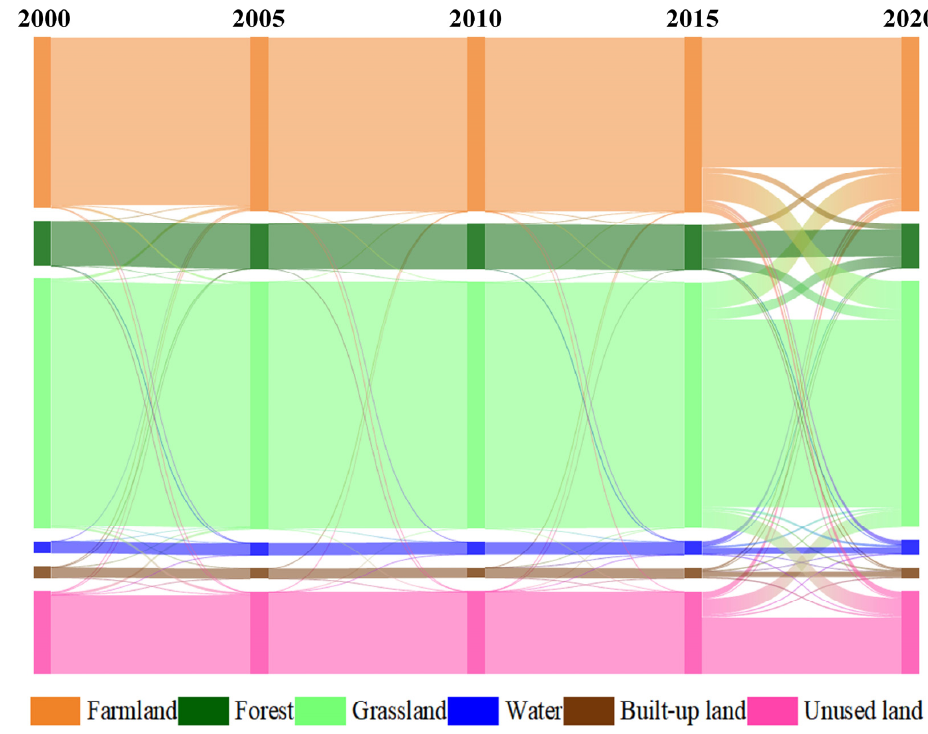
Figure 4. Land use transition from 2000 to 2020.